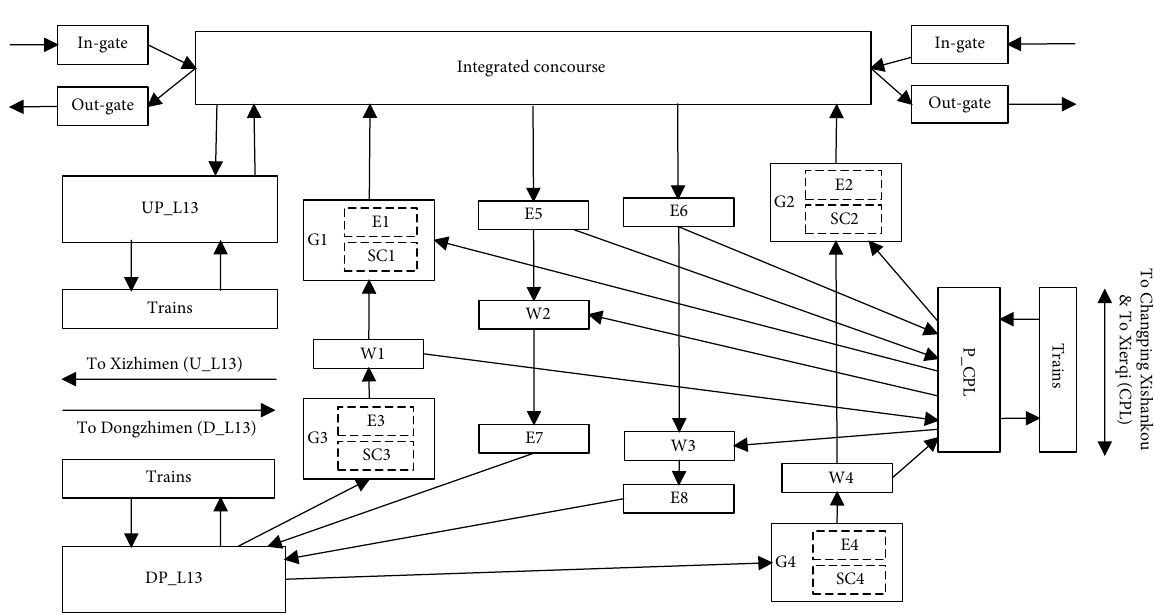
Figure 6: Number of passengers per half-hour in Xierqi station.